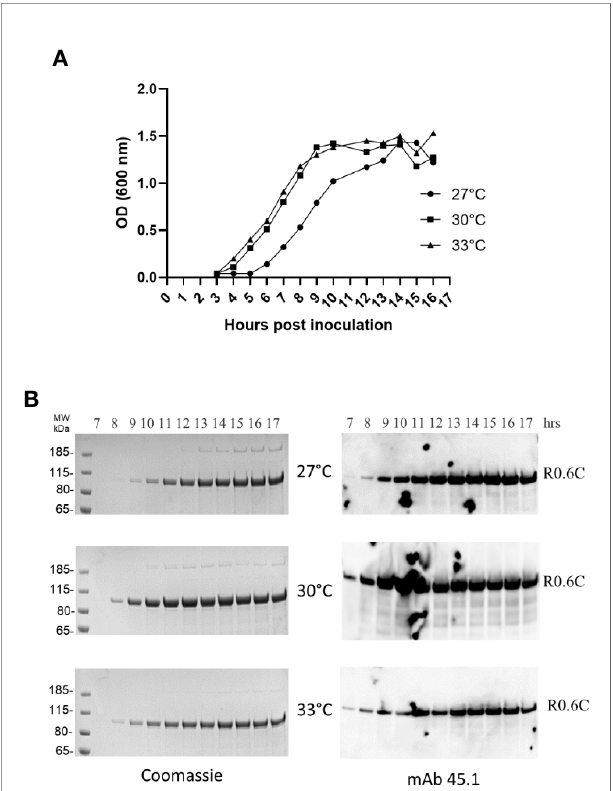
FIGURE 1 | Time course analysis of R0.6C expression in L.lactis at different temperatures. (A) Optical density measurements at 600 nm from 3 to 17 h of bacterial growth at 27, 30, and 33°C. (B) Samples collected from 7 to 17 h were assessed by Coomassie and immune blotting analysis. Samples were analysed without a reducing agent. Left panel , Coomassie blue-stained 4% – 12% polyacrylamide gel. Right panel , immune blotting analysis of the same gel shown to the left using the conformational reduction-sensitive mAb45.1 as primary